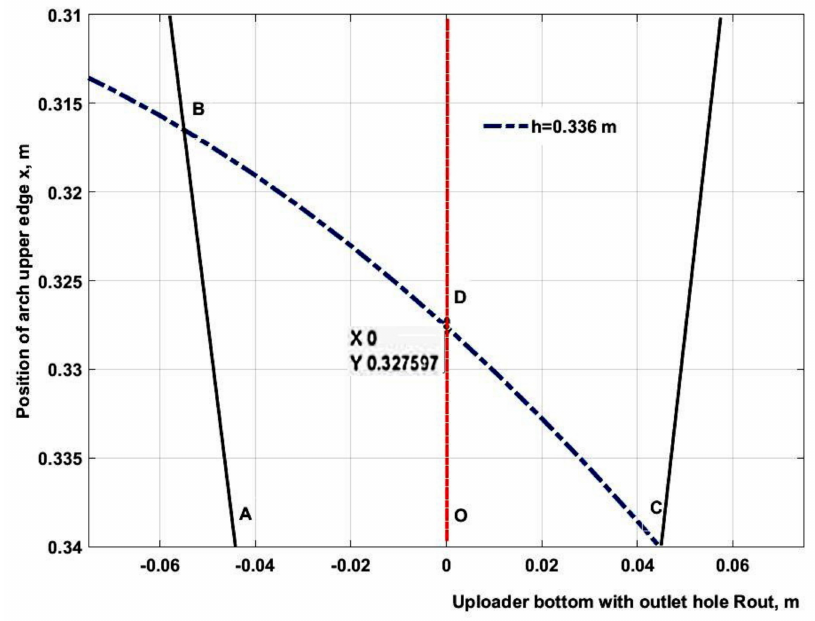
Figure 5. Grain layer position in the unloading hopper before it leaves the outlet hole. It is clear from Figure 5 that the inhomogeneity of the grain flow from the outlet hole develops because of the displacement of the center of bridging in grain leftward in